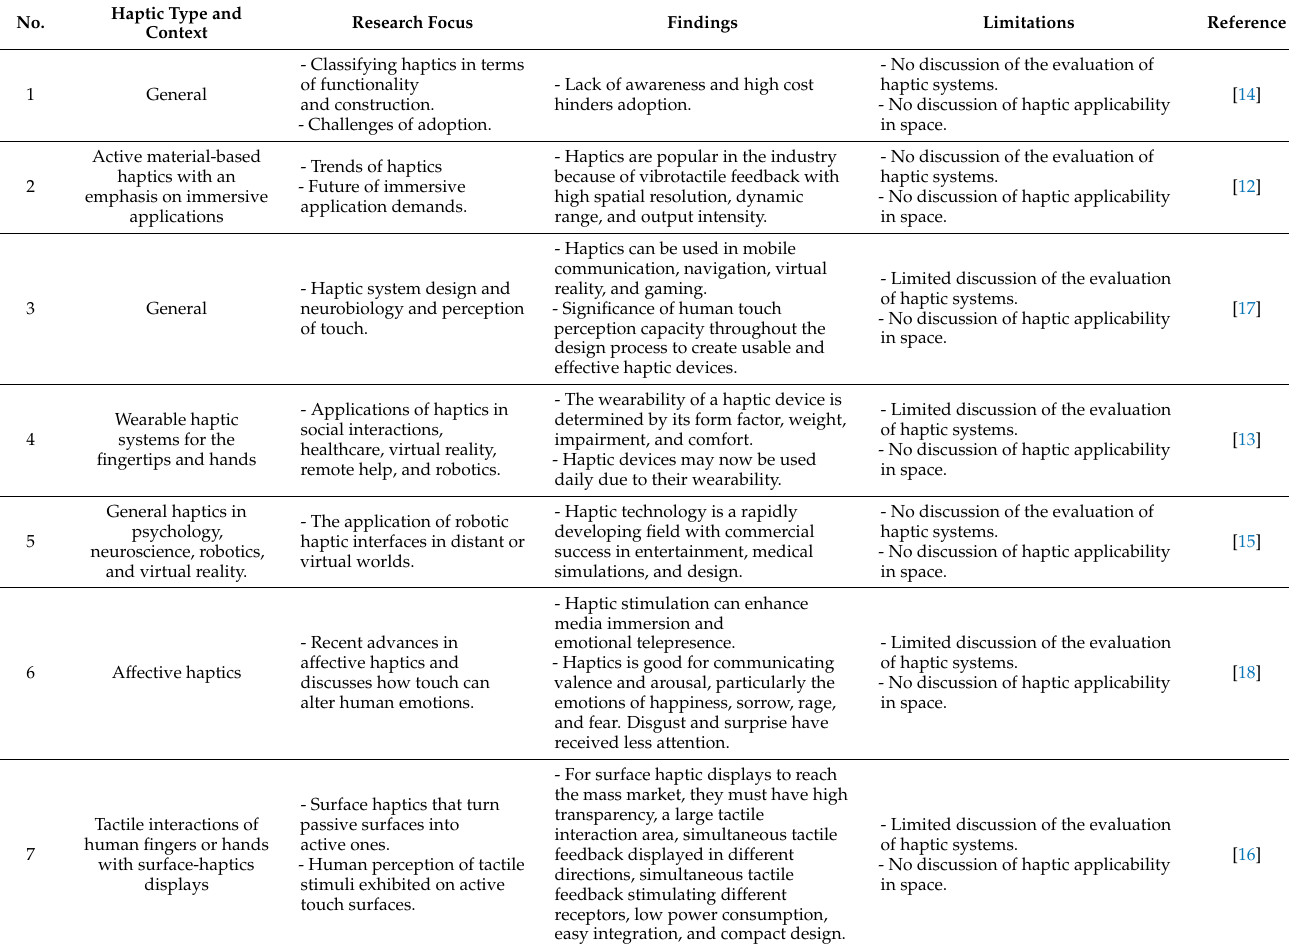
Table 1. An overview of review studies on